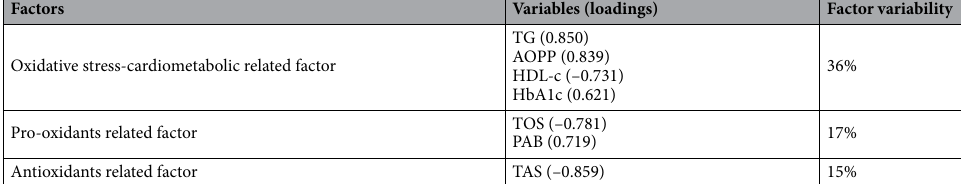
Table 4. Factors extracted by principal component analysis with percent of variability and variables’ loadings. TG-Triglycerides; AOPP-Advanced oxidation protein products; HDL-c-High density lipoprotein cholesterol;